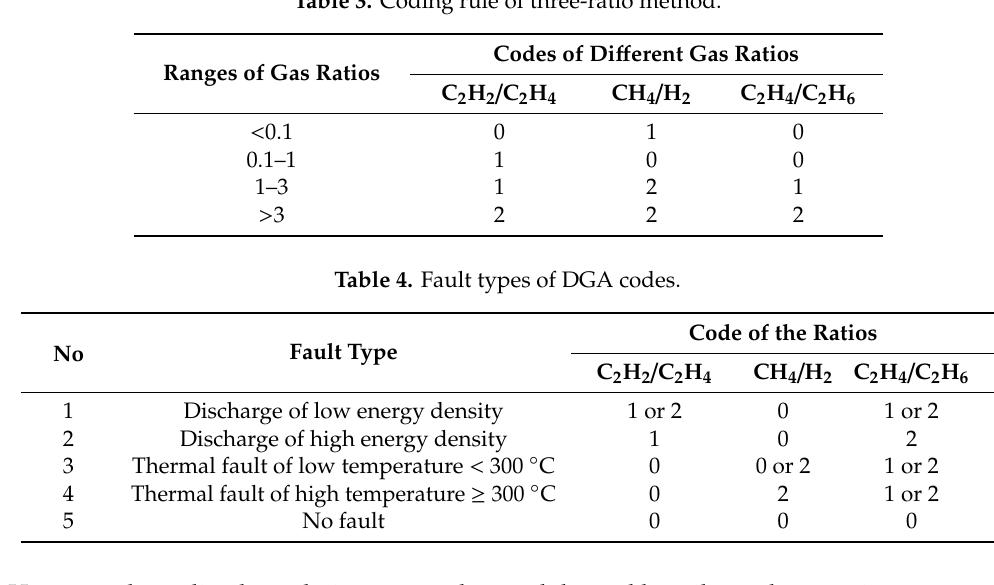
Table 3. Coding rule of three-ratio method.